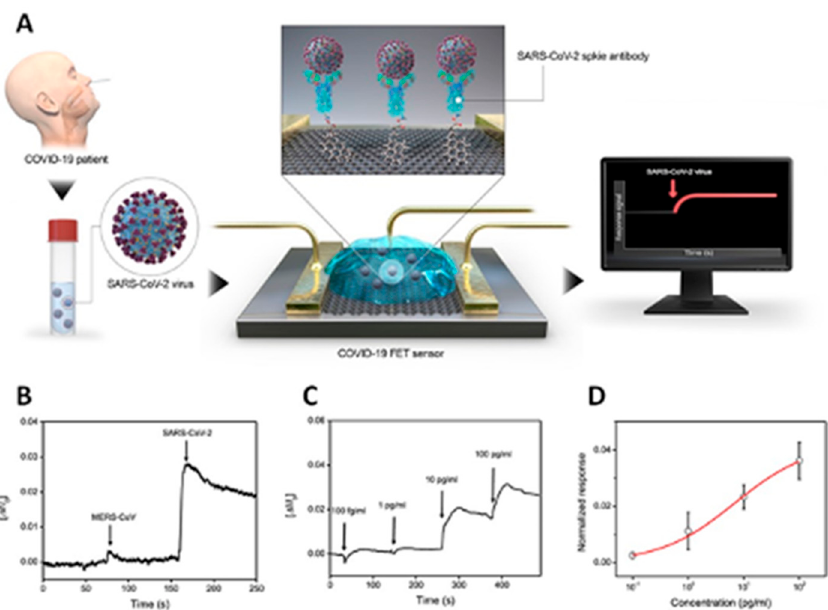
Figure 10. COVID-19 field-effect transistor biosensor: ( A ) working principle; ( B ) specificity to SARS-CoV-2; ( C ) current response as a function of antigen concentration; and ( D ) correlation curve between current response and antigen concentration. Adapted from Reference [238] with permission from the American Chemical Society.